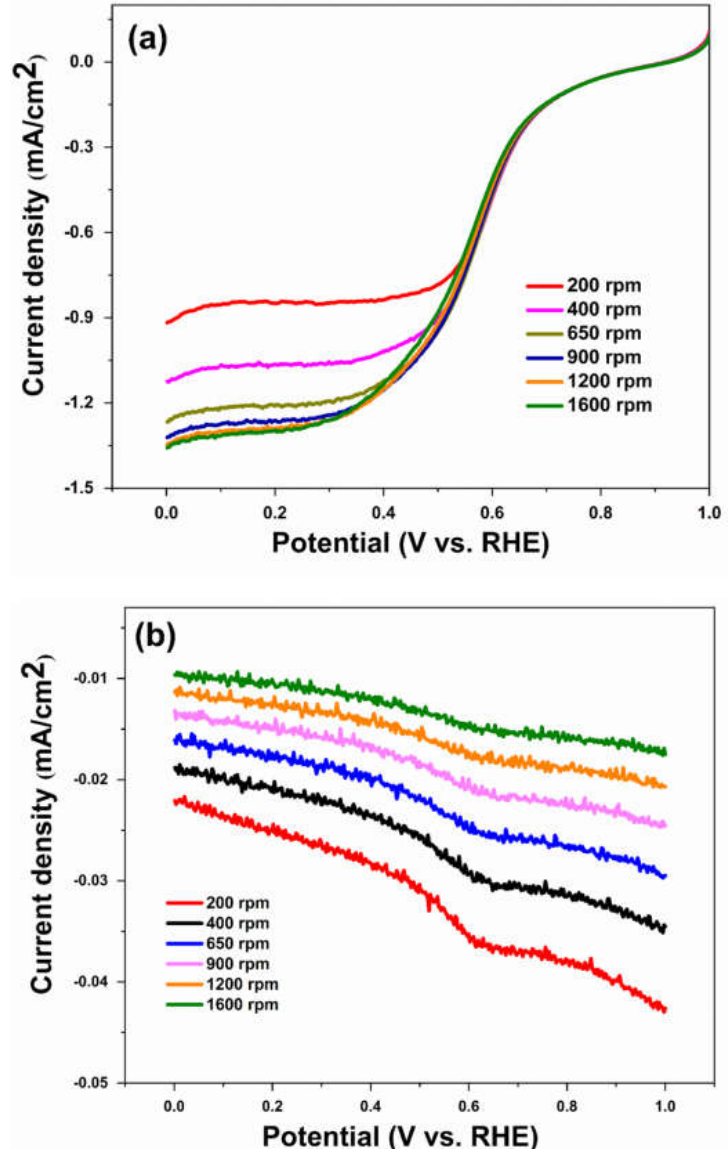
Figure 5. ( a ) The disk current density and ( b ) the ring current density curves of MWCNT-Nafion-Pt electrocatalyst using a rotating disk electrode loaded at various rotation rates in oxygen saturated 1.0 M H 2 SO 4 using 10 mV/s scan rate.